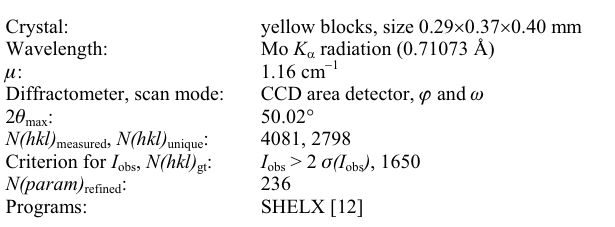
Table 1. Data collection and